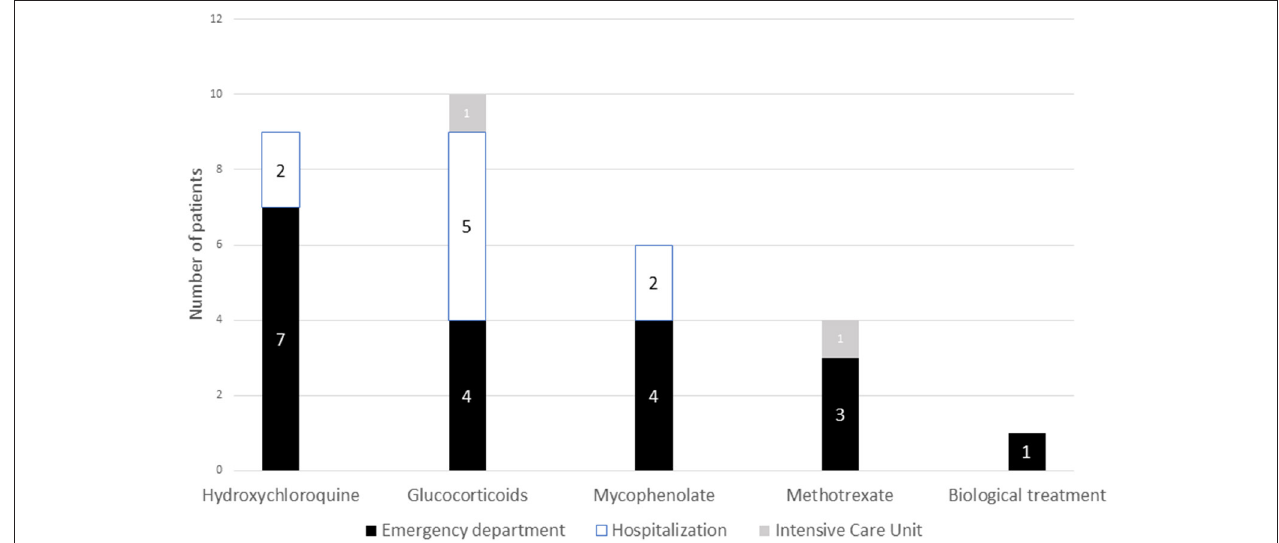
FIGURE 2 | Association between the treatment of systemic autoimmune diseases and severity. Number of patients in each of the immunosuppressive treatments and type of need for hospital care.